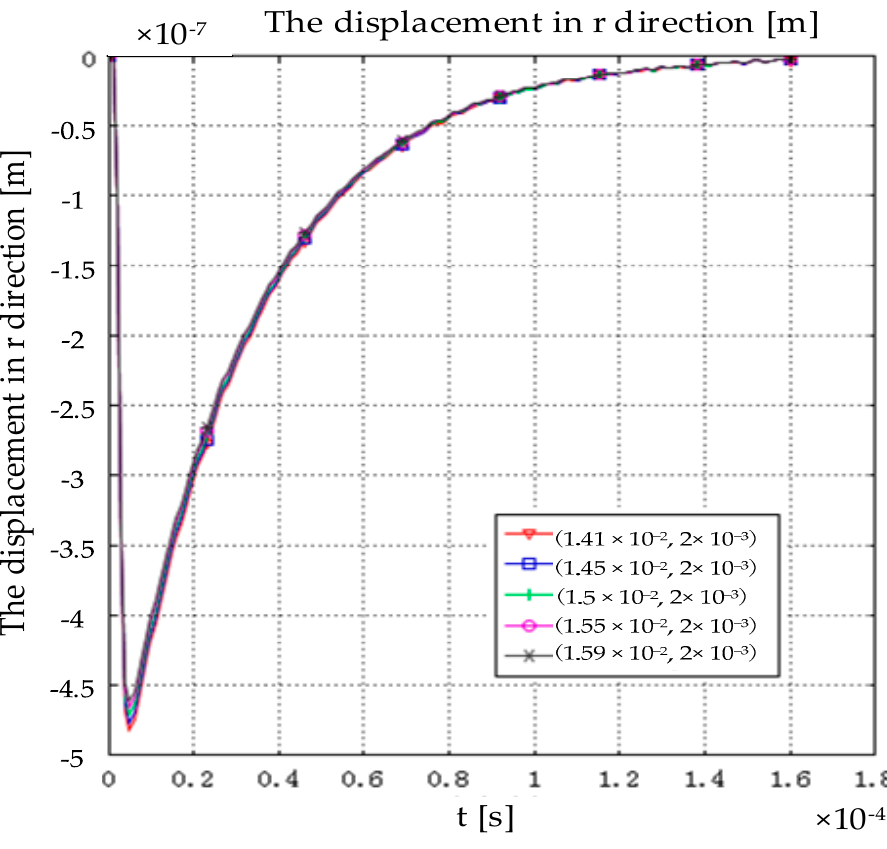
Figure 7. The displacement in r direction [m].